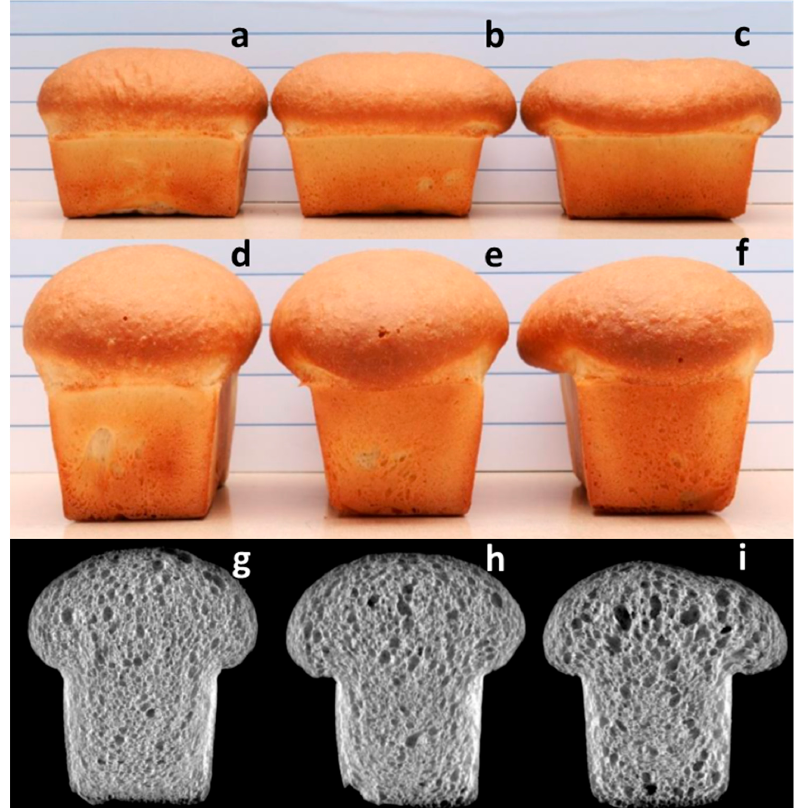
Figure 2. Bread loaves prepared from sound flour ( a , d , g ), 3% affected FDK flour ( b , e , h ) and 3% distorted FDK flour ( c , f , i ). Loaf volumes were comparable, however both FDK loaves exhibited loaf top collapse (top and middle rows) and contained a more open crumb structure with larger open cells. These deformities are indicative of protein damage.